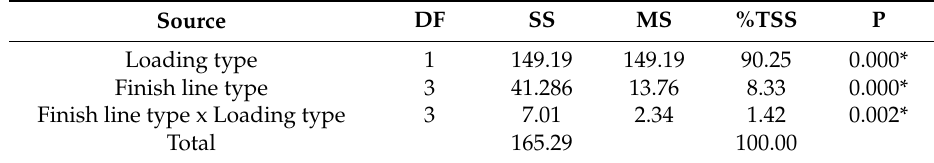
Table 2. Summary of the analysis of variance (ANOVA) showing the statistical results of the maximum stresses of different loading and finish line types concerning the primary molar.